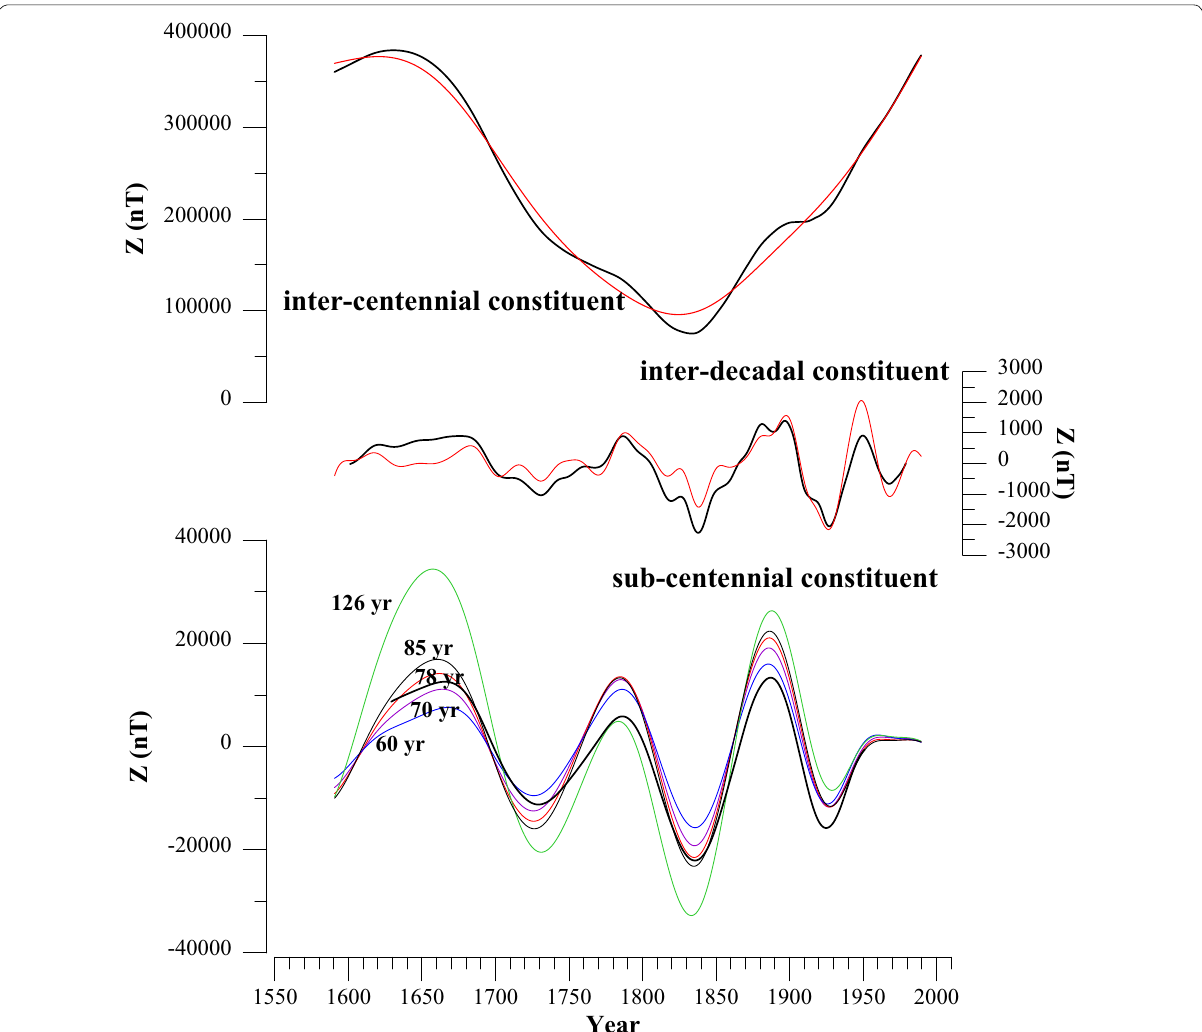
Fig. 8 Core surface radial field and its constituents. Upper plot: black— gufm1 unfiltered time series of the radial core field (location of NGK observa- tory); red—the inter-centennial constituent. Middle plot: inter-decadal constituent of the core surface field; Butterworth (color, cutoff—22 years) and running averages (black, 22-year window) filters. Lower plot: sub-centennial constituent of the gufm1 core surface field; Butterworth (color) and running averages (black) filters (numbers on curves—the cutoff/window